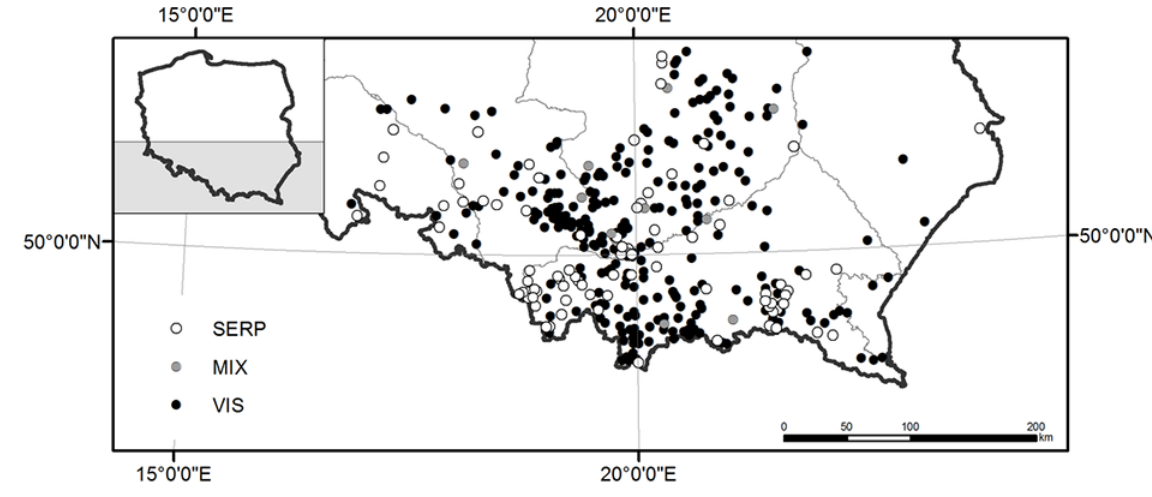
Fig. 6 Distribution map of different morphotypes of Arenaria serpyllifolia s. l. in southern Poland, based on material analyzed. white dots – SERP; grey dots – MIX; black dots –